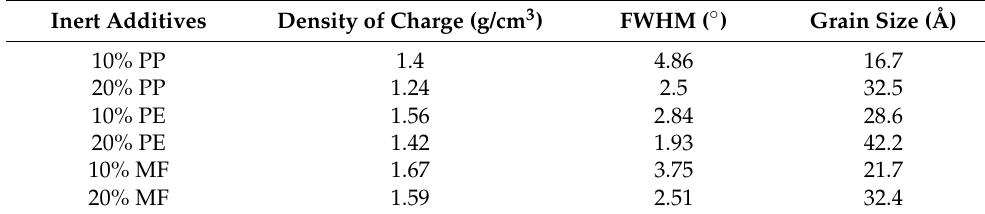
Table 5. The XRD data of the purified products.